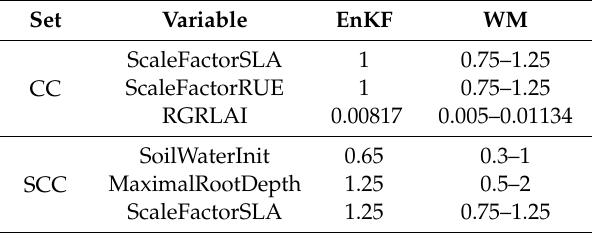
Table 2. Initial mean values for variables that were used by the Ensemble Kalman Filter (EnKF) to create a Gaussian distribution for ensemble generation, and range of values used by the Weighted Mean (WM) to create a uniform distribution for the ensemble generation. Two sets of variables were used: the crop component (CC) set or the combinational set of soil and crop components (SCC). Set